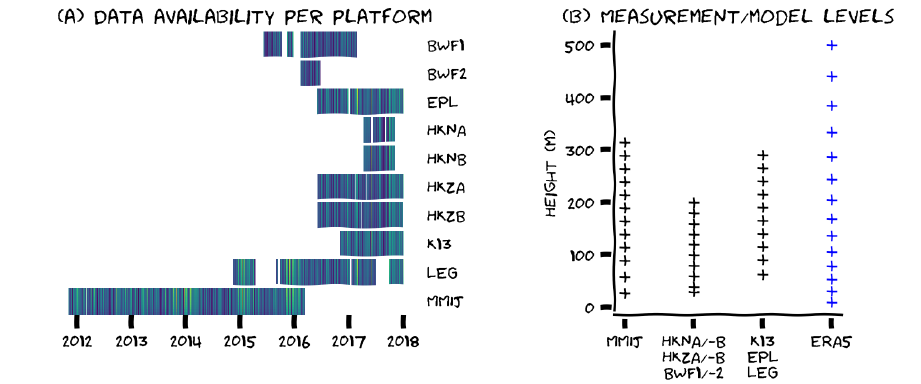
Figure 2. (a) Time–height plots of wind speed for each platform, illustrating the data collection periods, temporal overlap between plat- forms and episodes of missing data. (b) Site-specific measurement heights. Reference elevation for the ERA5 data have been included for comparison. The colour coding in (a) highlights episodes of high (yellow/green) and low (blue) wind